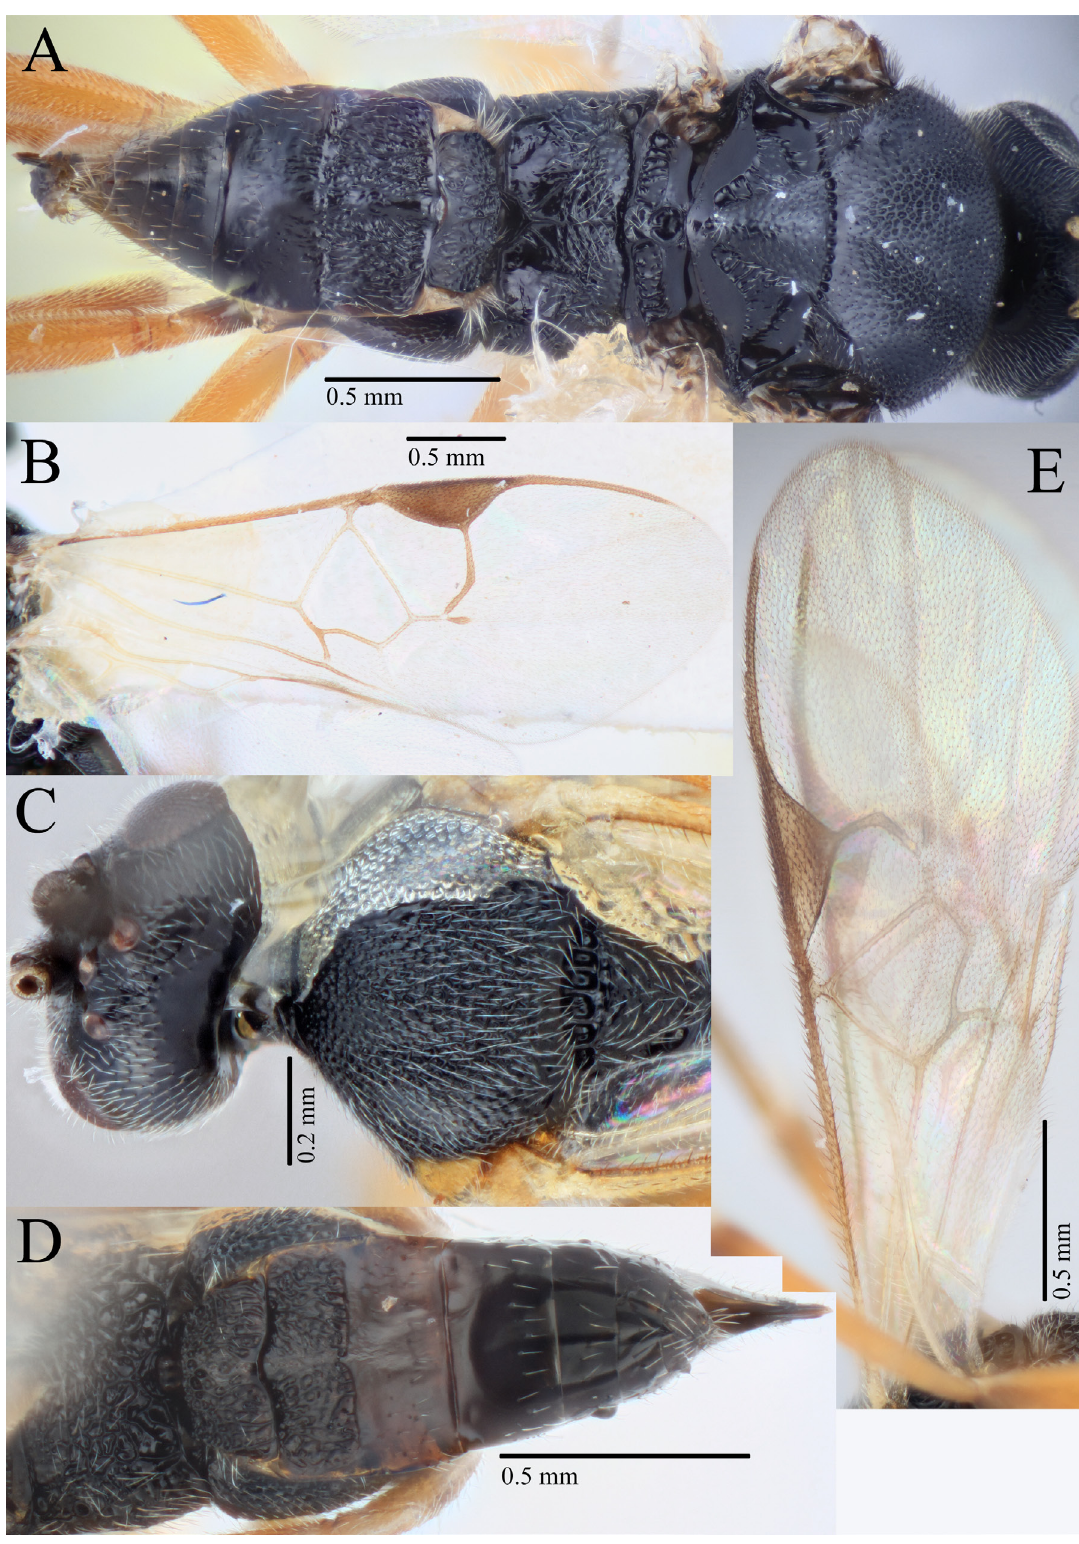
Fig. 31. A–B . Cotesia urabae Austin & Allen, 1989, paratype, ♀ (WINC). A . Habitus in dorsal view. B . Fore wing. C–E . Cotesia vestalis (Haliday, 1834), ♀ (WINC). C . Head in dorsal view and anteromesoscutum. D . Propodeum and dorsal metasoma E .